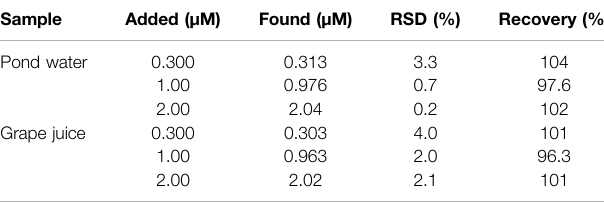
TABLE 2 | Recovery of CBZ in diluted pond water and grape juice.